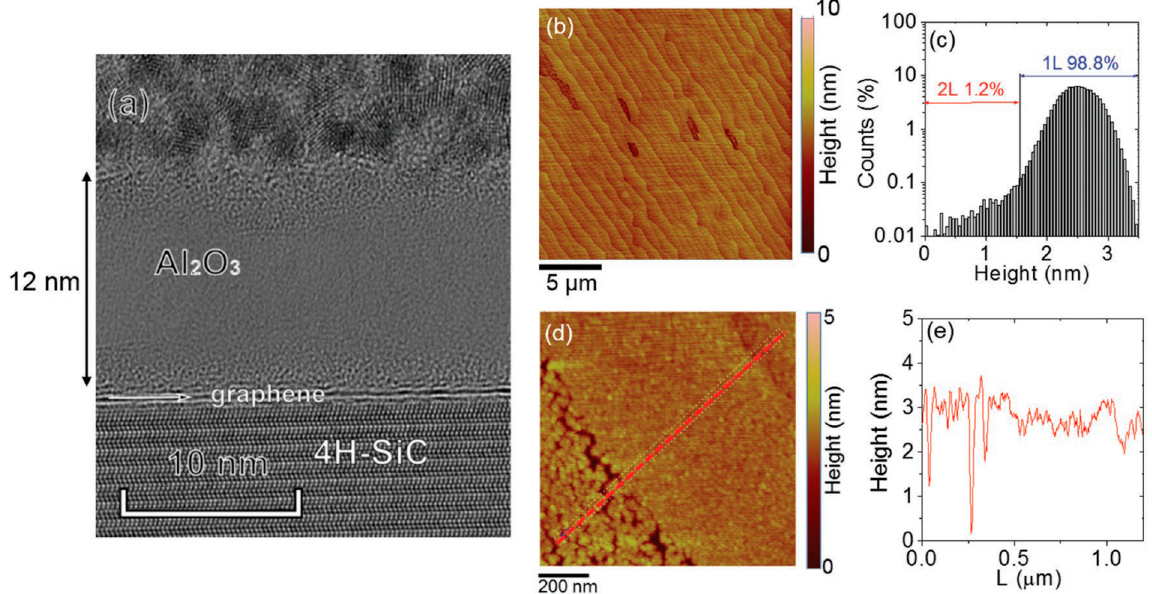
Figure 14. ( a ) Cross-sectional TEM image of the 12 nm-thick ALD-grown Al 2 O 3 film on monolayer epitaxial graphene on SiC. ( b , c ) illustrate the AFM image of the same film corresponding histogram of island height values. ( d , e ) represent a higher resolution AFM image of the same film and height line scan of Al 2 O 3 at the boundary region between monolayer graphene regions and bilayer graphene inclusion [44]. Copyright 2019 WILEY-VCH Verlag GmbH & Co. KGaA, Weinheim, Germany.